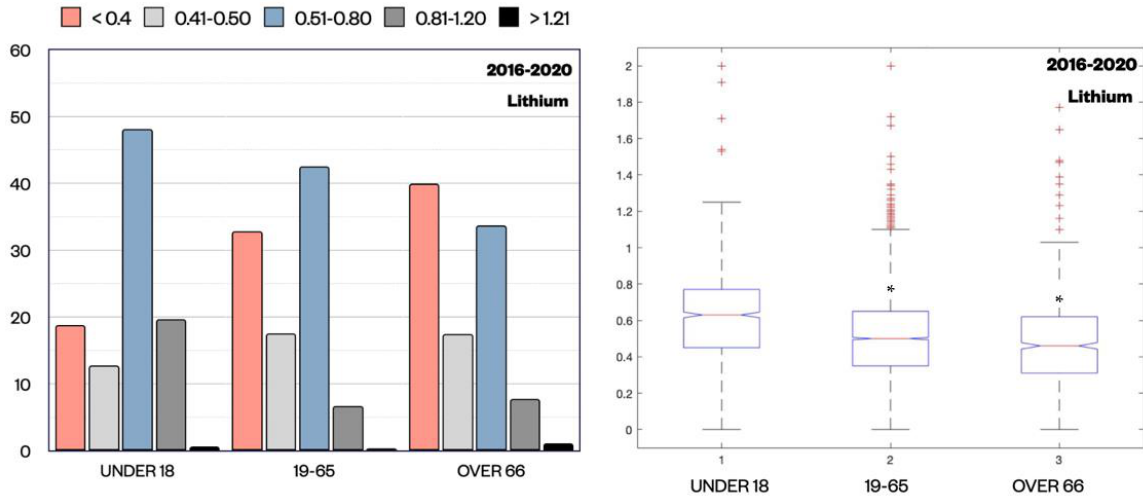
Figure 4. Distribution of lithium Cp (mmol/L) expressed as percentage for each subpopulation divided by ranges (<0.4, 0.41–0.50, 0.51–0.80, 0.81–1.20, >1.20) and by age groups (under 18, 19–65, over 66). Z-test revealed a statistically significant difference in Cp distribution proportions across age groups, in particular for samples < 0.4 mmol/L and between 0.5 and 0.8 mmol/L. The median value of lithium Cp (mmol/L) for each age group is also shown. * p < 0.001 compared to the group under 18 by Kruskal – Wallis test (+ outliers samples are marked).